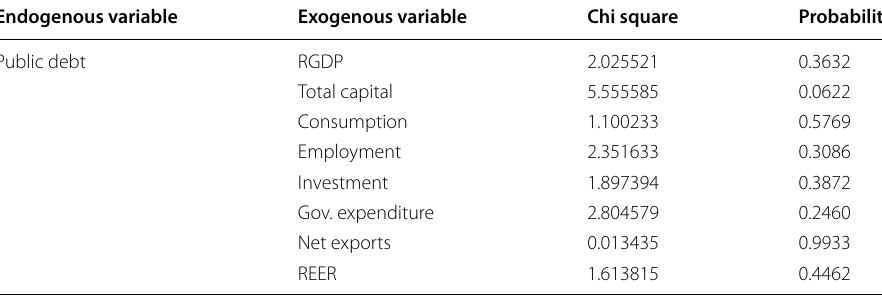
Table 9 Wald test results for Eq. (5). Source :Author’s calculations